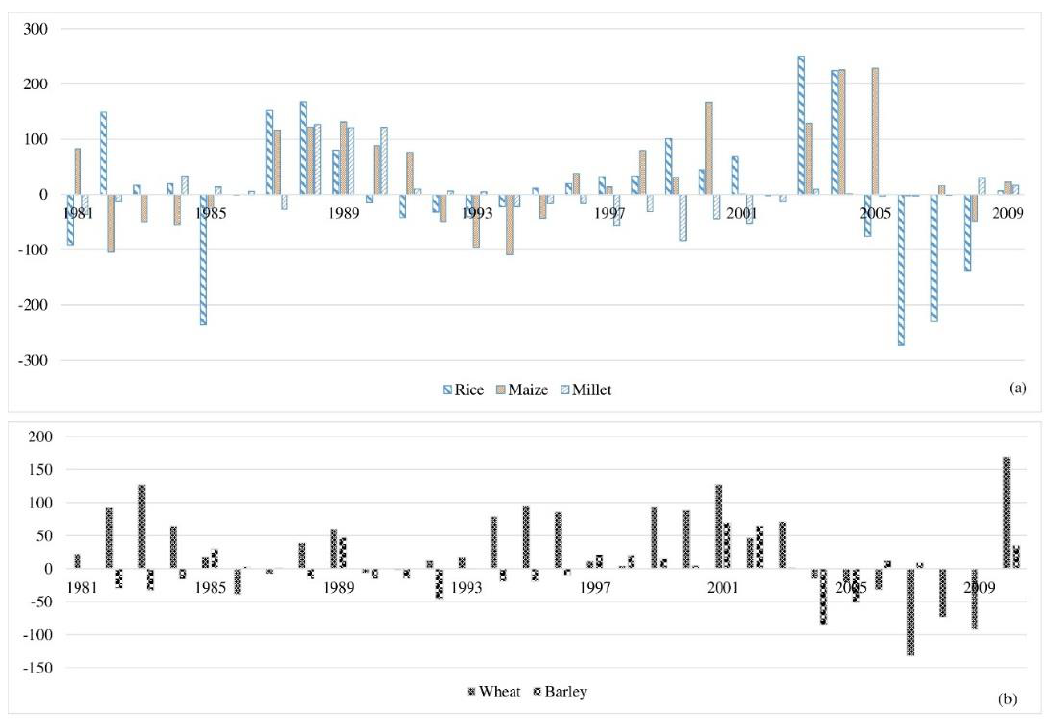
Figure 7. ( a ) Anomalies in the summer crops yield; ( b ) Anomalies in the winter crops yield.